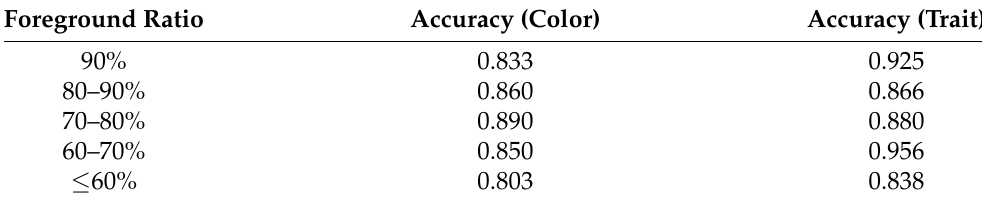
Table 2. Results on medical scenes with three color